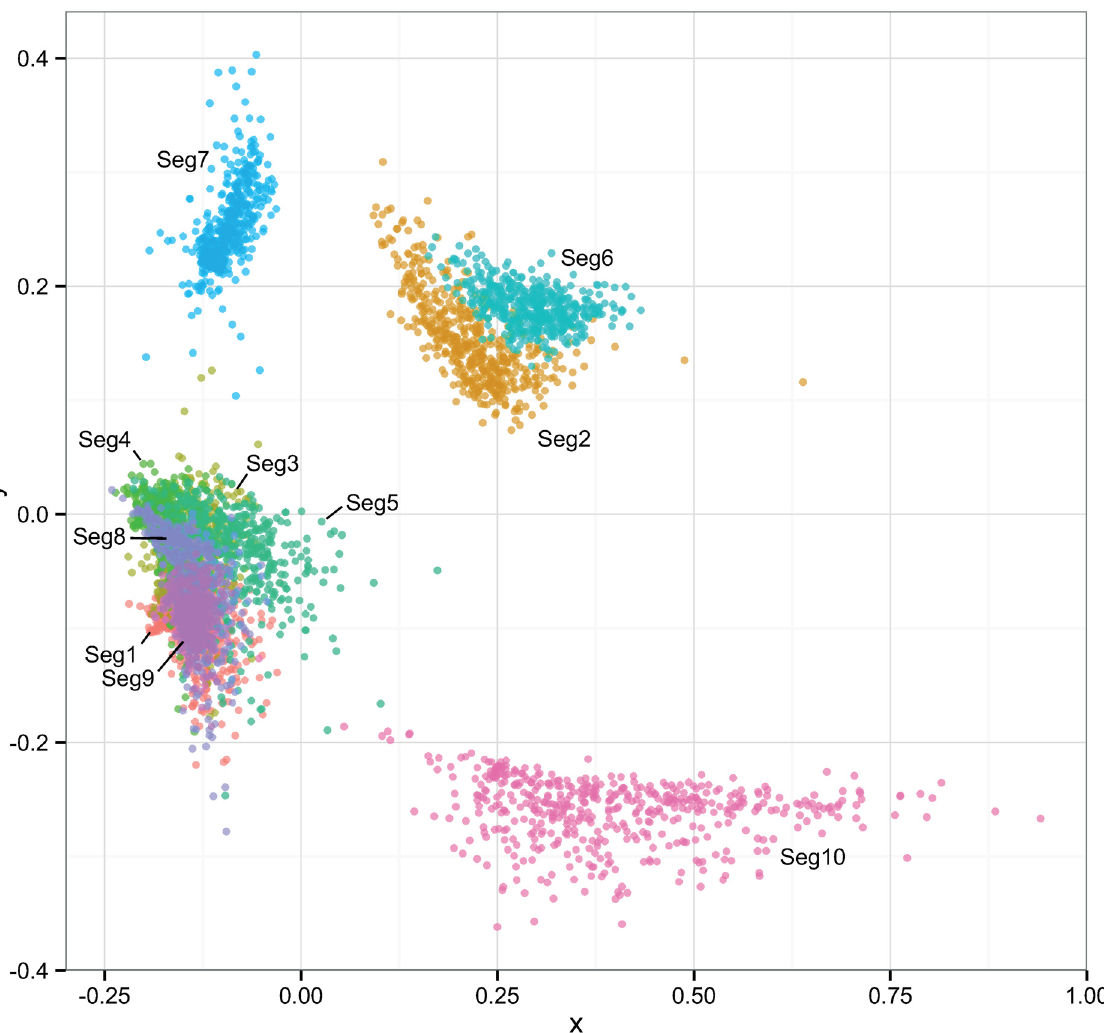
Fig 8. Multi-dimensional scaling plot reflecting correlations in the times to most recent common ancestor (tmrca) between pairs of European BTV viruses. Temporal estimation was done separately for each of the ten BTV segments to degree to which their evolutionary histories were shared. Clouds of points reflect phylogenetic uncertainty based on 500 trees sampled in program BEAST for each segment with pairwise comparisons to other segments being limited to viruses sampled in the same year. Only the first two dimensions of the scaling are shown in the